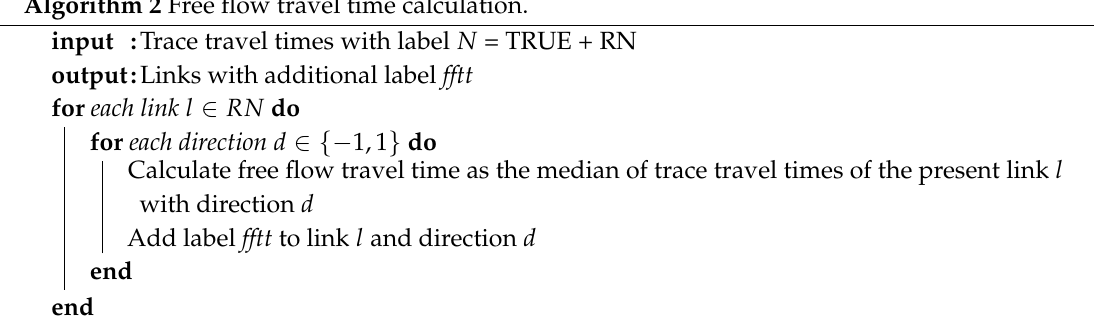
Algorithm 2 Free flow travel time calculation.